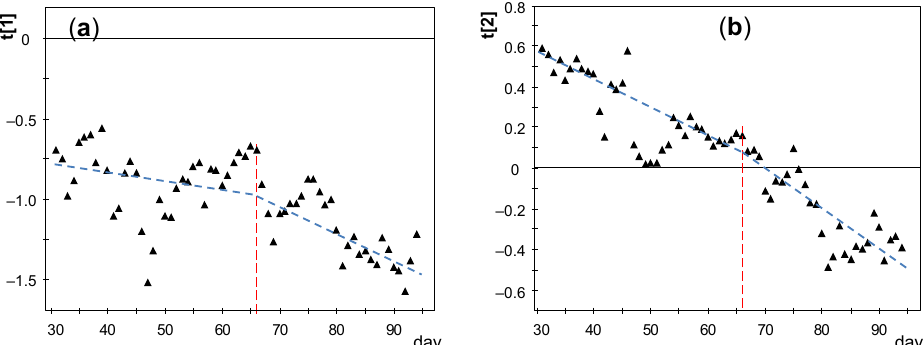
–1.5–1.0–0.50 Figure 19. PCA of daily medians for the period of days 31–94 after discarding nodes CH1 and OUT: ( a ) evolution of scores Figure 19. PCA of daily medians for the period of days 31 − 94 after discarding nodes CH1 and OUT: ( a ) evolution of scores corresponding to PC1, ( b ) evolution of scores corresponding to PC2. corresponding to PC1, ( b ) evolution of scores corresponding to 0.3 Figure 20. PCA of daily medians for the period of days 31 − 66 after discarding nodes CH1, OUT, and SAC: ( a ) loading plot for PC1 and PC2 ( p[2] vs. p[1] loadings), ( b ) time series of daily median temperatures from day 31 − 66. Trajectories were averaged according to clusters indicated in ( a ). Taking into account that p[1] loadings are strongly correlated with the mean, a lower temperature was observed for RE1 and RE2 compared with the rest of nodes at the retable. The reason could be that both nodes are located close to a thick wall supporting the altar- piece, so that their recordings seem to be influenced by the temperature of that wall. The changes in the correlation structure of variables between days 1–30 versus 31–66 can be discussed by comparing Figures 18a and 20a. The main difference corresponds to nodes at the altarpiece, which now appear closer to each other compared with the first stage. Generally speaking, UP nodes tended to record higher temperatures than those at lower 0.2 0.1 0 –0.1 –0.2